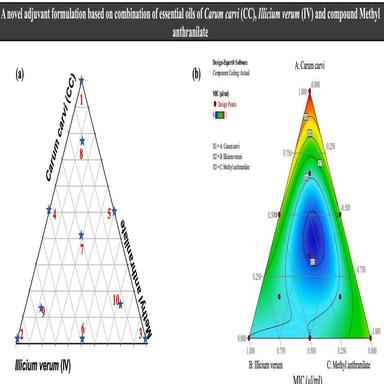
Augmented simplex-centroid design assay (a) Experimental design points, and (b) 3D response surface plot of MIC.